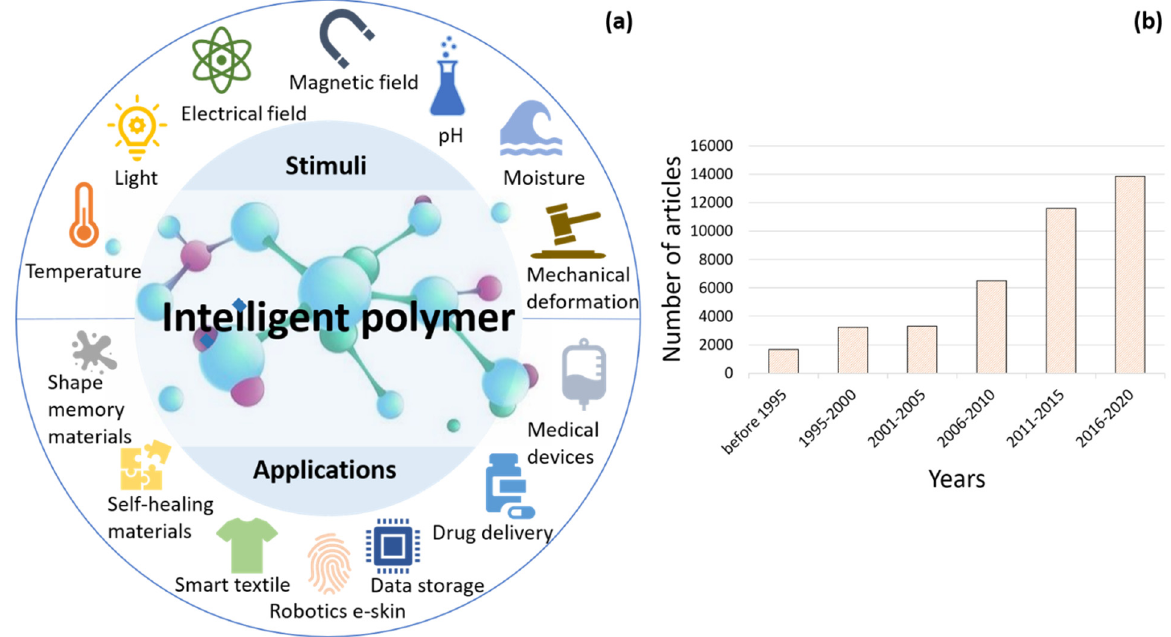
Figure 1. An overview of intelligent polymer development: ( a ) stimuli-responsive intelligent polymers and their diverse applications; ( b ) progress in intelligent polymer applications: an inclination in publications. Data derived from Scopus [24].